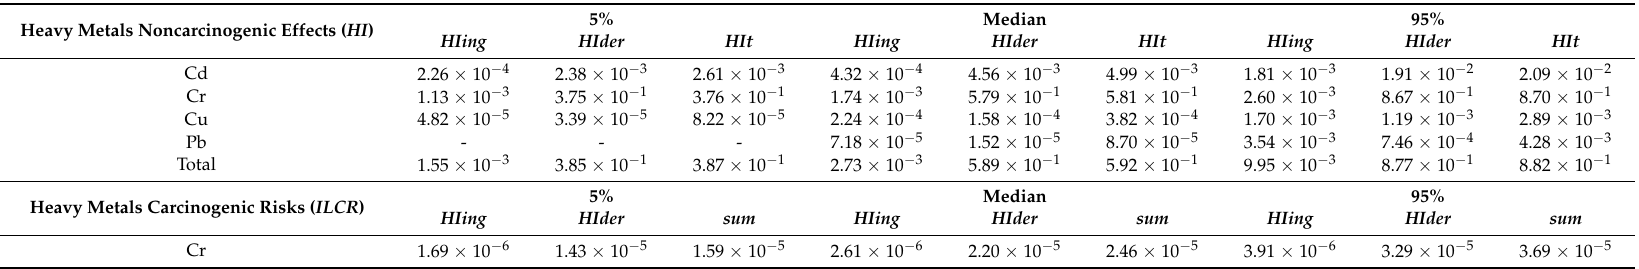
Table 7. Summary of Xi’an ( n = 50) non-carcinogenic Hazard Index ( HI ) and carcinogenic Incremental Lifetime Cancer Risk ( ILCR ) via ingestion and dermal exposure of DW based on HMs at the 5th, median and 95th percentiles.